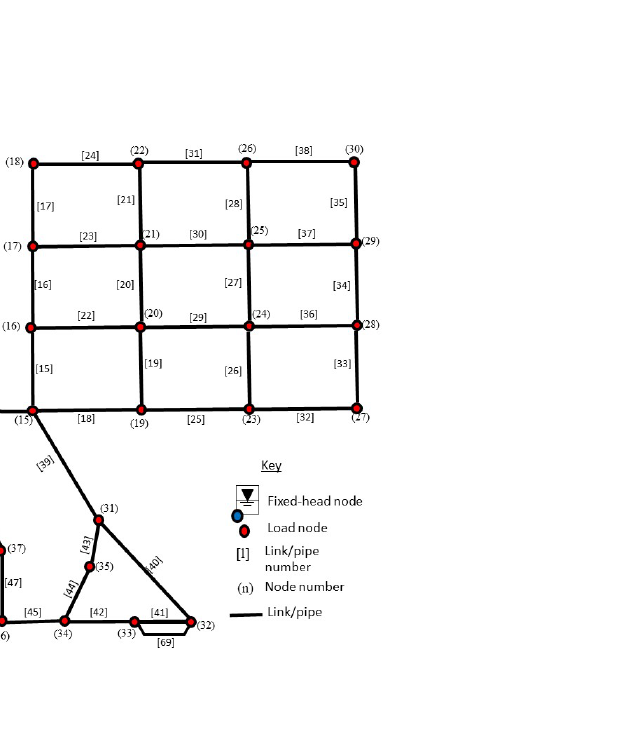
Figure 4. Schematic for Illustrative Example 2 Kumar et al.